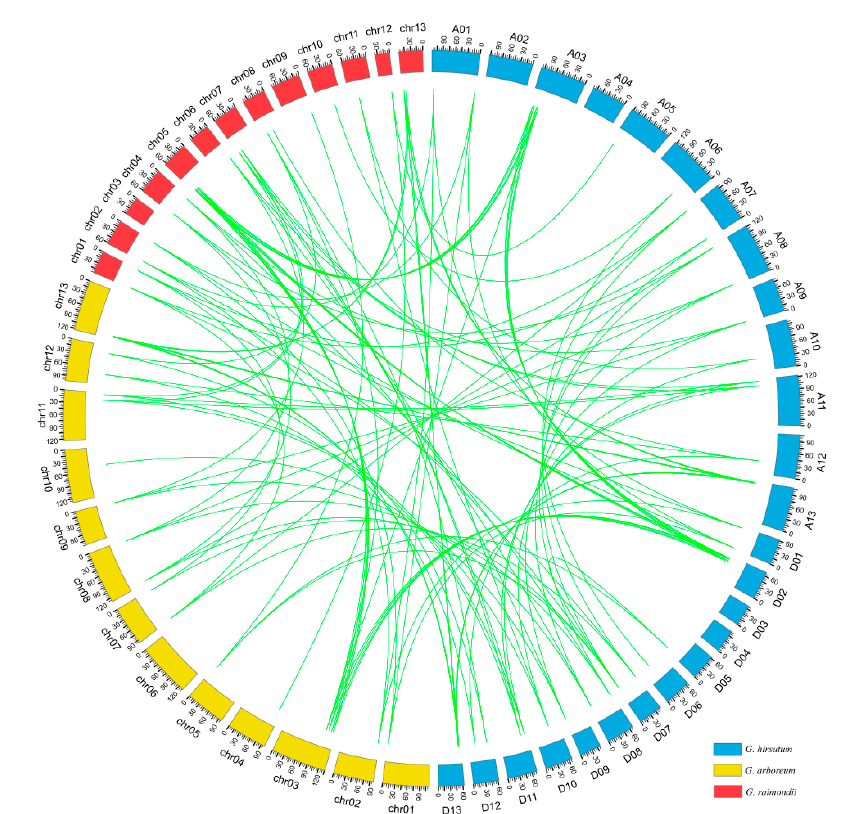
Figure 4. TPX2 homologous gene pairs among G. arboreum, G. raimondii, and G. hirsutum.